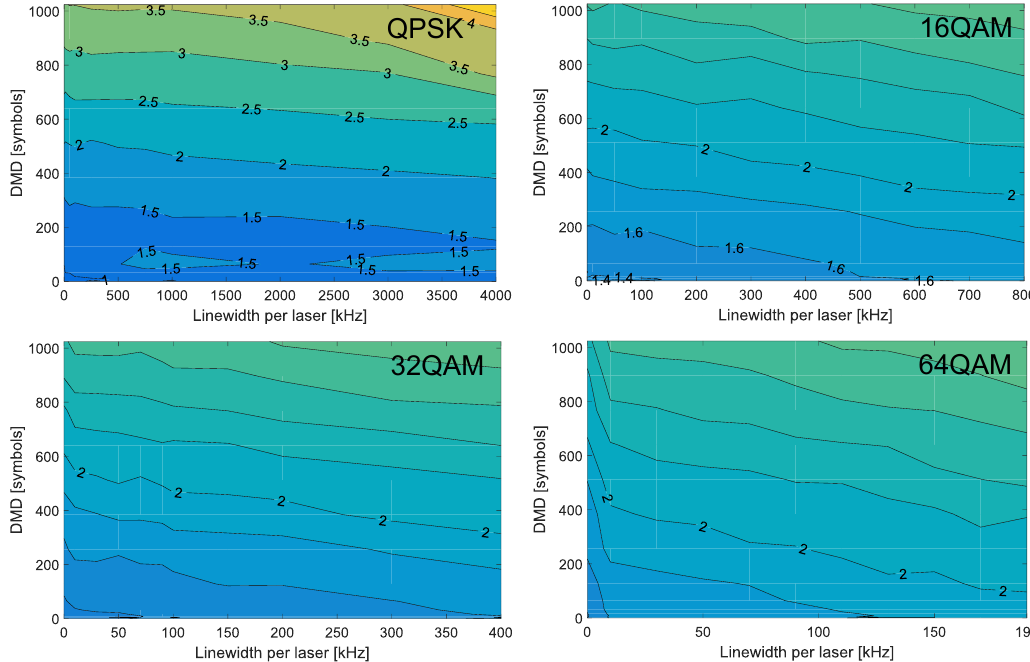
Figure 7. OSNR penalties in dB, computed at a BER of 10 − 4 , for model A and QPSK, 16-QAM, 32-QAM and 64-QAM modulation formats.